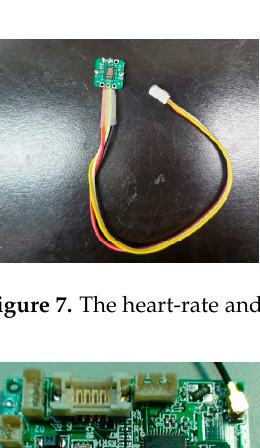
Figure 6. Network hierarchy with node types and compound node ID.